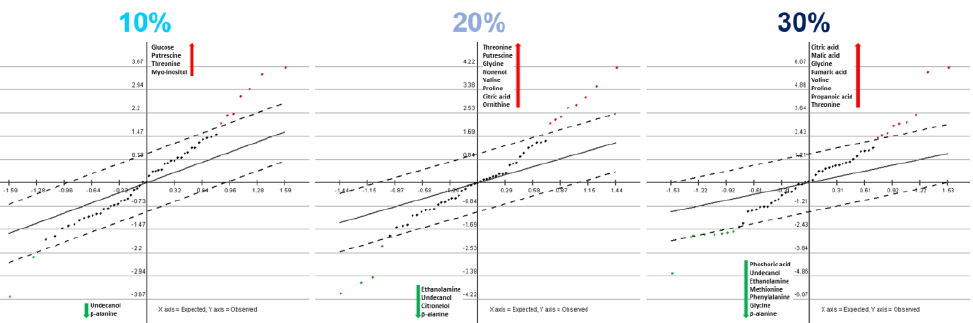
Figure 5. Significance Analysis of Microarrays (SAM) for each exposure compared with the unexposed control reveals the gradual change in the most significant metabolites.